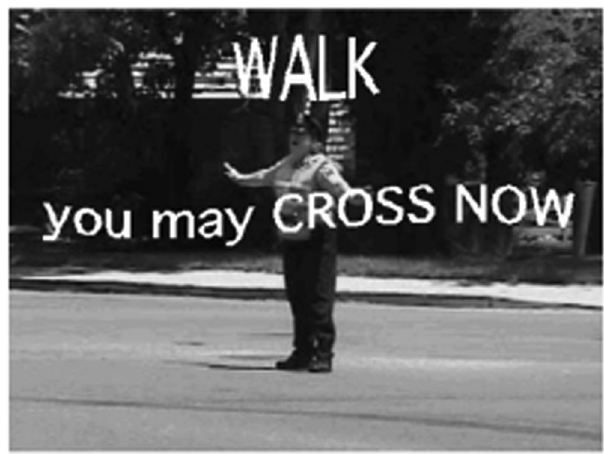
Fig. 1 Selected example from Norris (2004, p. 8). The policeman ’ s spoken language is treated as a multimodal construct where the pitches and intonation are visualized through various fonts in the wave-shaped annotation, along with his